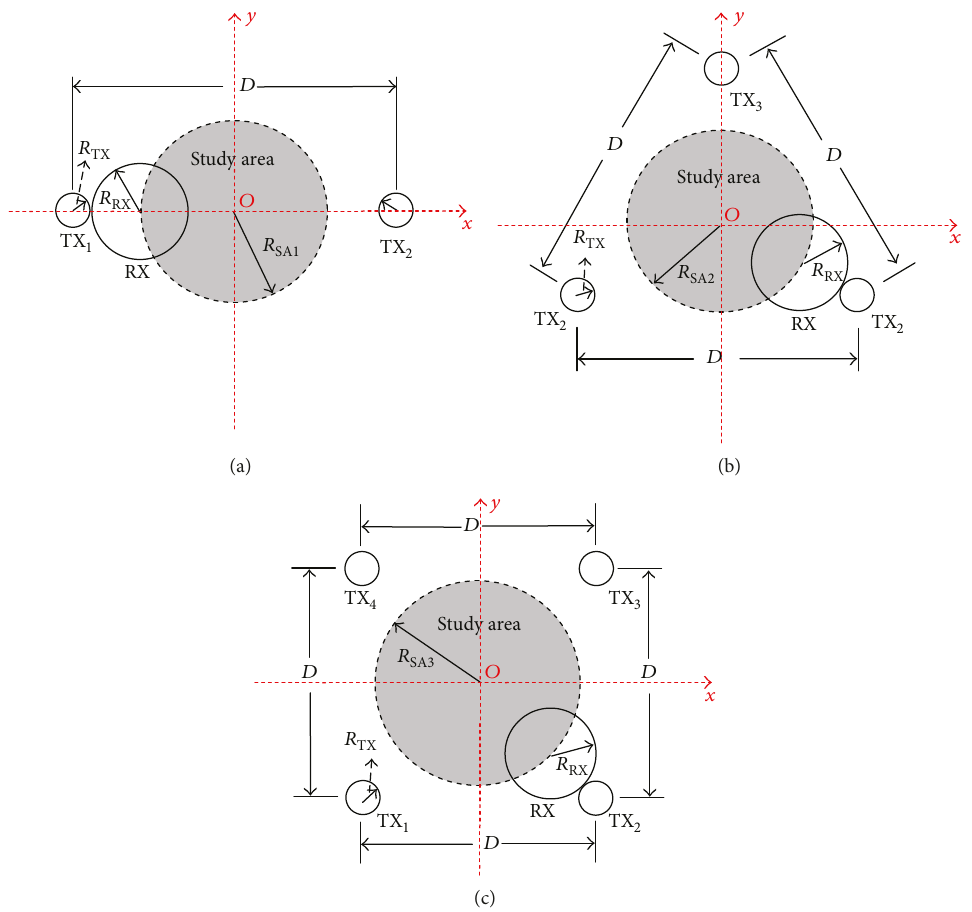
Figure 3: Spatial layout for a multiple-TX single-RX system: (a) two TX, (b) three TX, and (c) four TX. Table 1: Dimensions of system